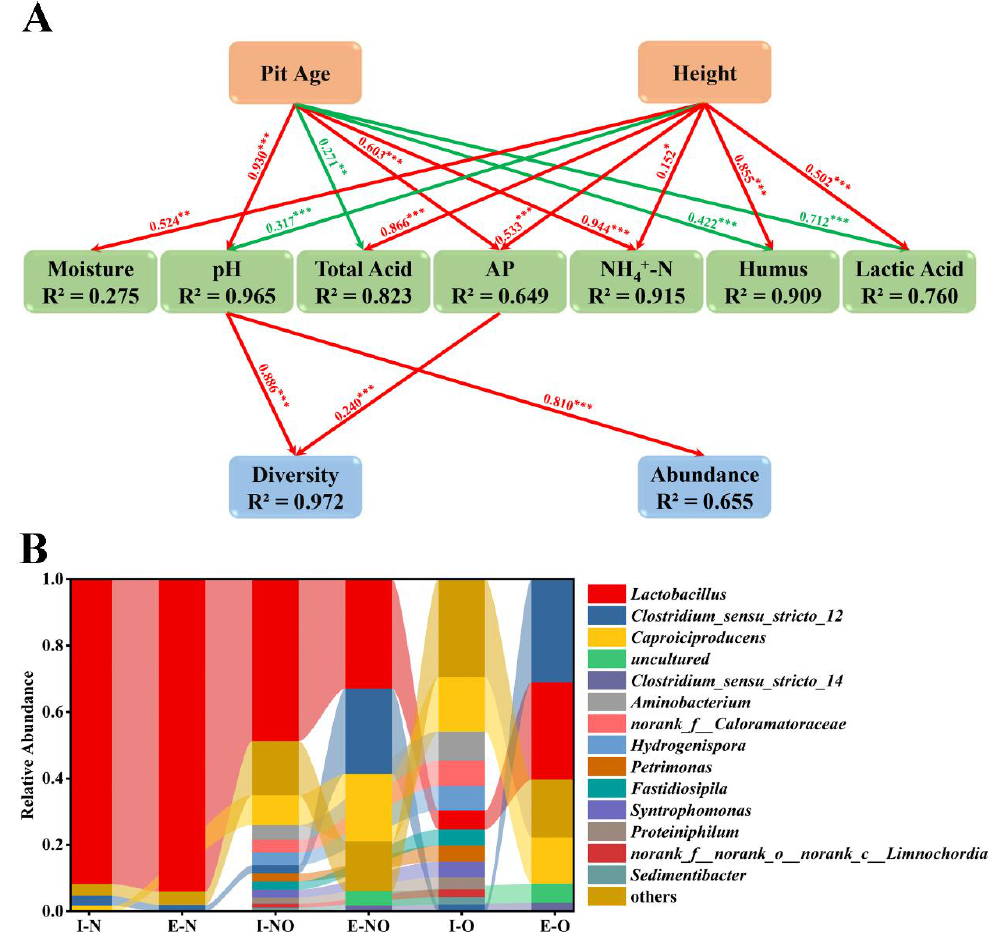
Figure 4. ( A ) Structural equation modeling revealed correlations between pit age, height, physico- chemical properties, and bacterial communities. The red arrow indicates a positive correlation, whereas the green arrow indicates a negative correlation. Significance levels are denoted as follows: * p < 0.05, ** p < 0.01, and *** p < 0.001. The R 2 values indicate the proportion of variance. ( B ) Values presented above the arrows indicate standardized path coefficients. Composition of the bacterial communities (at the genus level) found in different initial PWM and evolved PWM cultures. I and E indicate initial and evolved PWM cultures, respectively. N, O, and NO indicate NPWM, OPWM, and NPWM mixed with OPWM at a 1:1 ( w / w ) ratio,